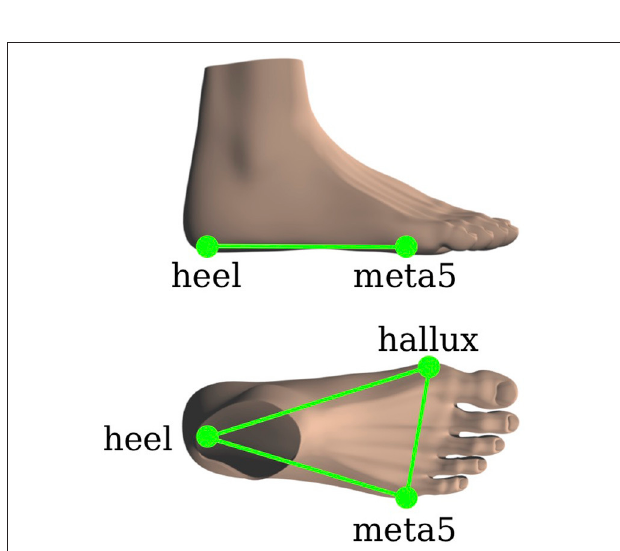
FIGURE 3 | Foot model with the three contact points hallux, meta5 , and heel .